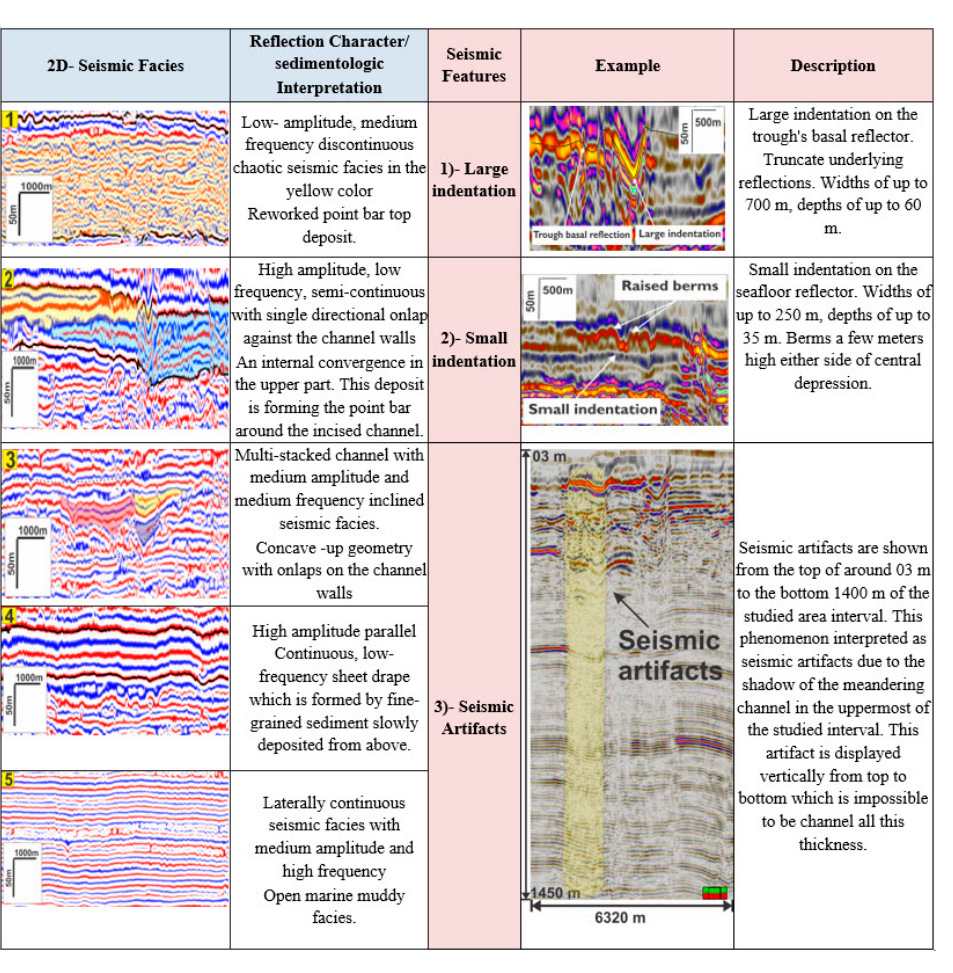
Figure 11. The seismic facies categorization of Cosine of Phase seismic attribute sections depends on continuity, the strength of reflection, and internal reflection patterns. This figure shows five different characterized seismic facies with three observed seismic features.